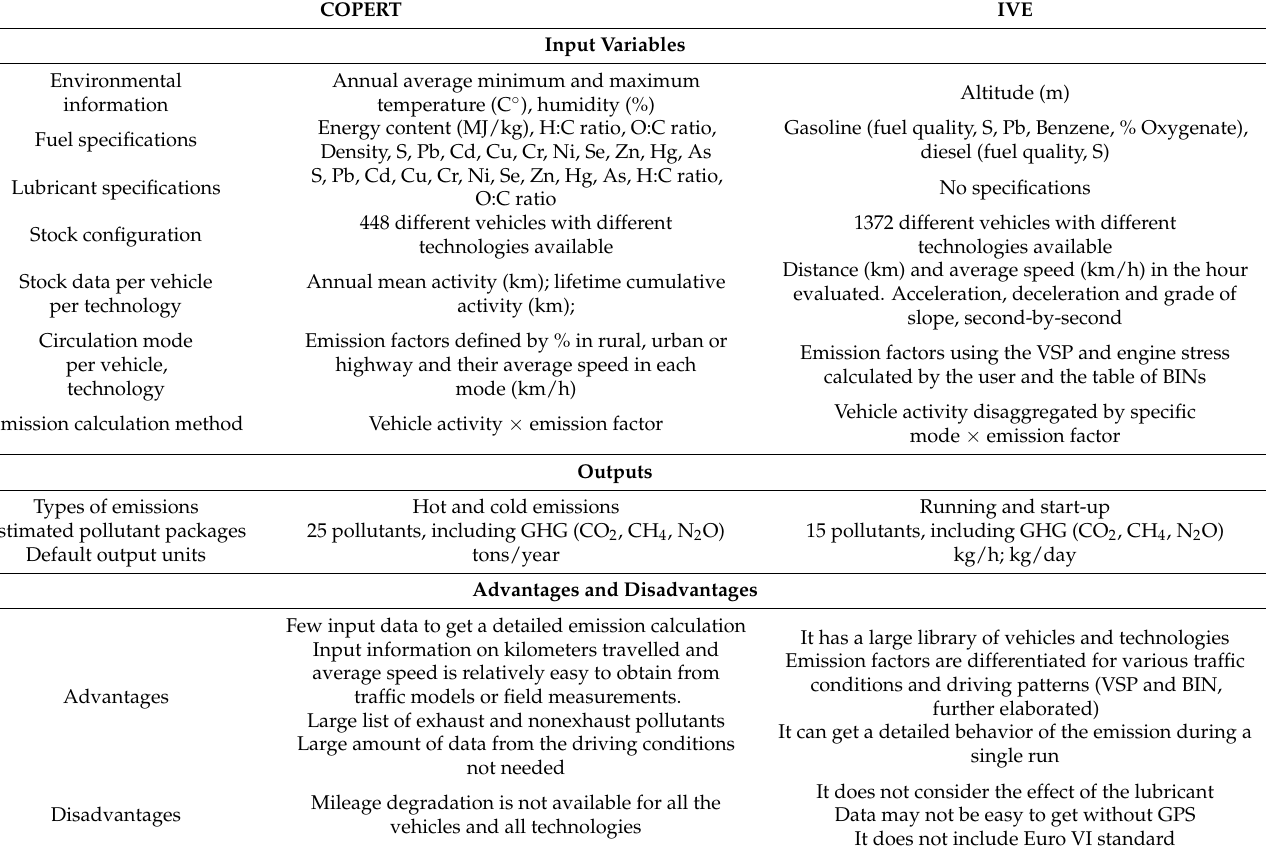
Table 1. Qualitative comparison between COPERT and